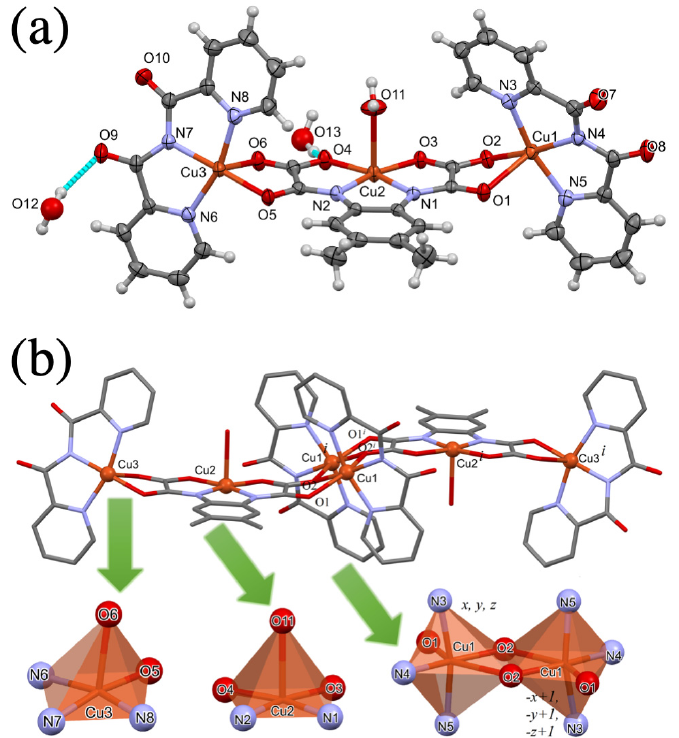
Figure 1. ( a ) Perspective view of the asymmetric unit of 1 with atom labeling scheme (H bonds involving the water molecules of crystallization are in cyan dotted lines; thermal ellipsoids at 50% probability level); ( b ) view of the centrosymmetric hexacopper(II) entity of 1 [symmetry code: (i) − x + 1, − y + 1, − z + 1] with a detail of the metal coordination polyhedra (hydrogen atoms and crystalli- zation water molecules were hidden for the sake of